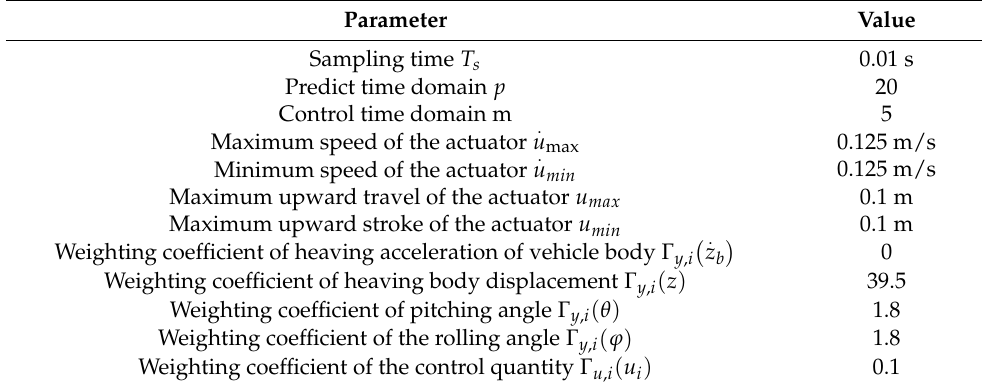
Table 2. Performance Index of the Control System.